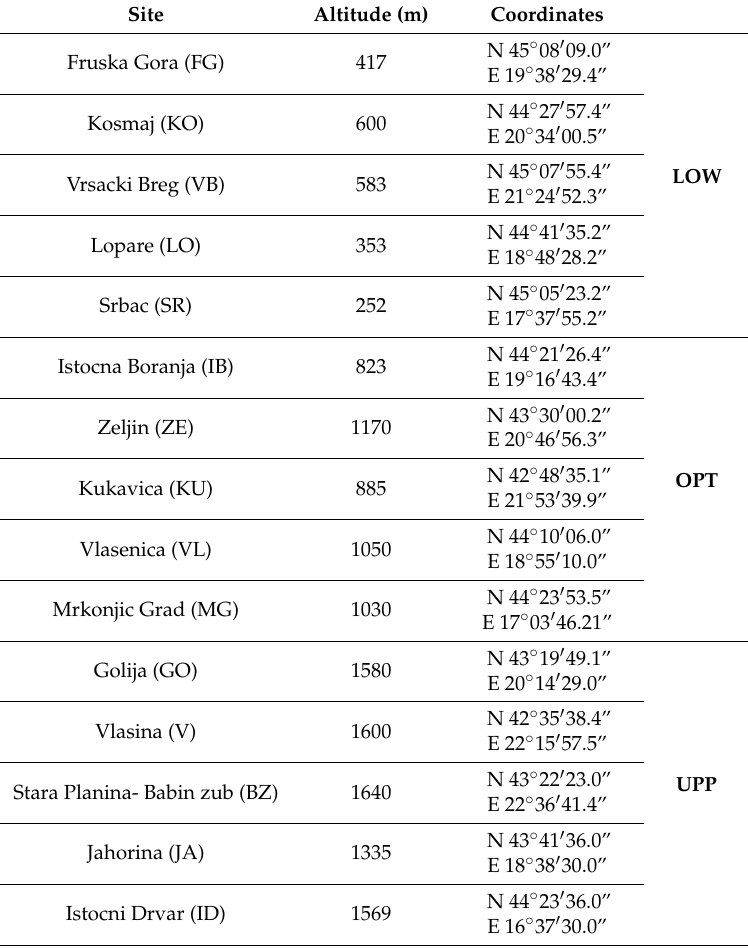
Table 1. Sampling sites in the Republic of Serbia and the Republic of